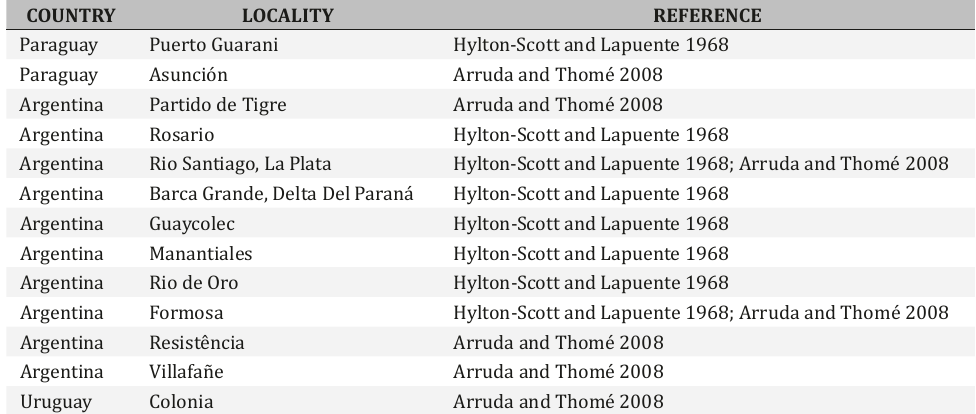
Previously known occurrences of